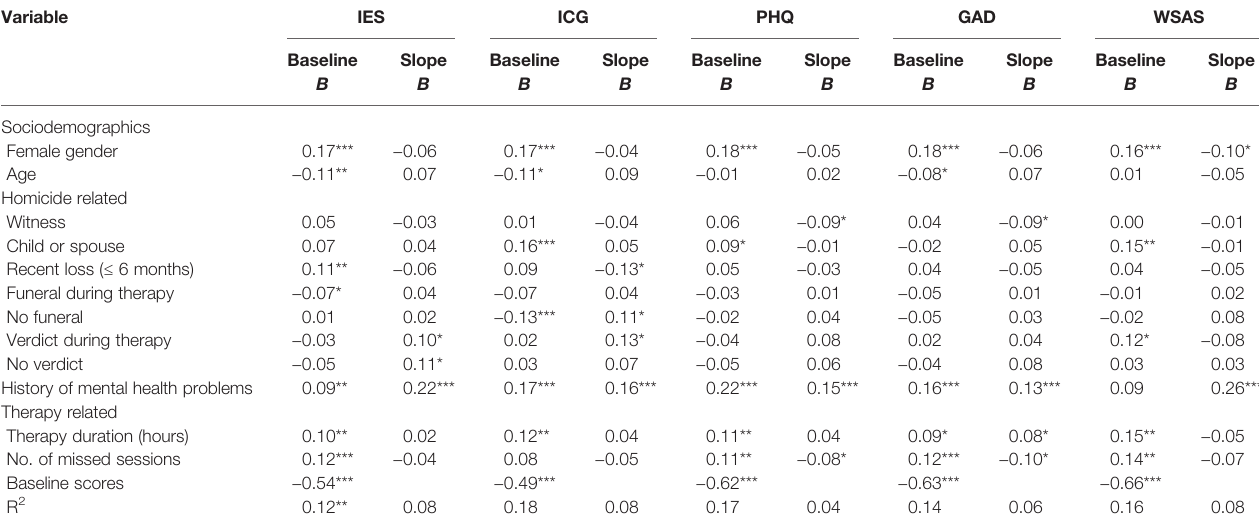
TABLE 3 | Associations of demographic and homicide characteristics, history of mental health problems, and therapy characteristics with symptoms of PTSD, PGD, general anxiety, depression, and functional impairment at baseline and change during treatment.